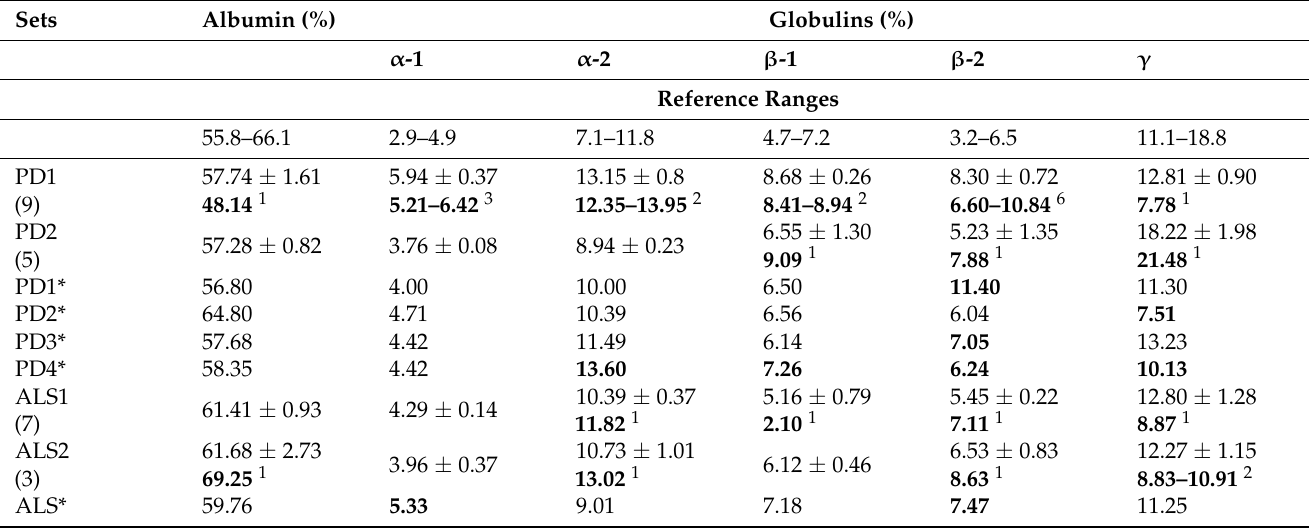
Table 3. Albumin and globulin concentrations (mean values and SD, and individual values) are shown in percentage of the total plasma protein for PD and ALS patients. The level of proteins out of the reference ranges is given in bold. The numbers in superscript denote the number of cases for the given set with certain protein level(s) out of the reference limits. The number of patients classified in sets is given in